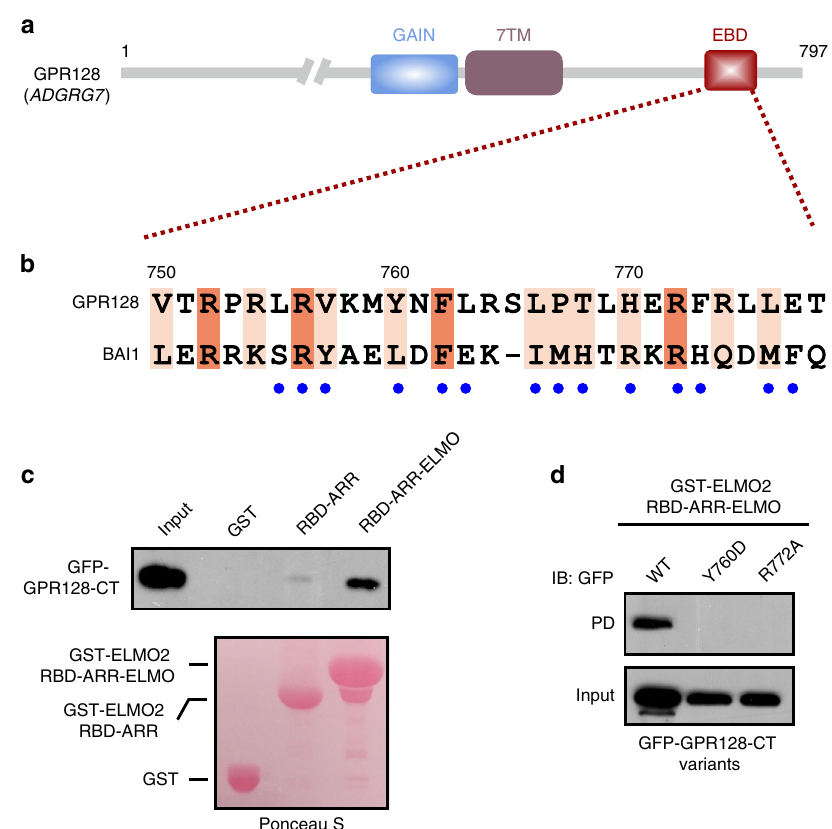
Fig. 6 GPR128 as another aGPCR upstream of ELMO family scaffolds. a Domain organization of GPR128. b Sequence alignment of the ELMO-binding domain from GPR128 and BAI1. In this alignment, the absolutely conserved and conserved residues are highlighted with orange and pink boxes, respectively. Residues of BAI1 involved in binding to ELMO2 are annotated below as blue dots. c GST-pull down assays showing that ELMO2-RAE, but not RBD-ARR tandem, speci fi cally binds to GPR128-CT. d Mutation of residues of GPR128-CT corresponding to those of BAI1 involved in ELMO2 binding blocked the GPR128/ELMO2 interaction in the GST-pull down assays. PD, pull down